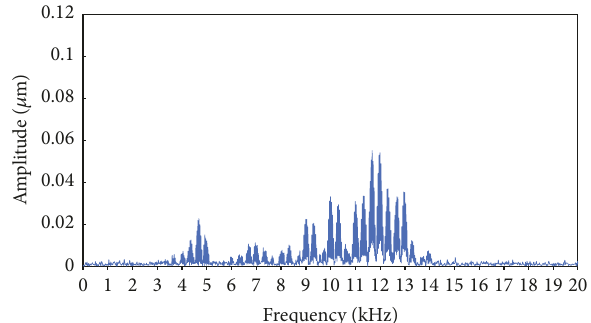
Figure 44: Spectrum of the residual signal obtained for the second scenario (seven consecutive cracked teeth with 30% CLP).